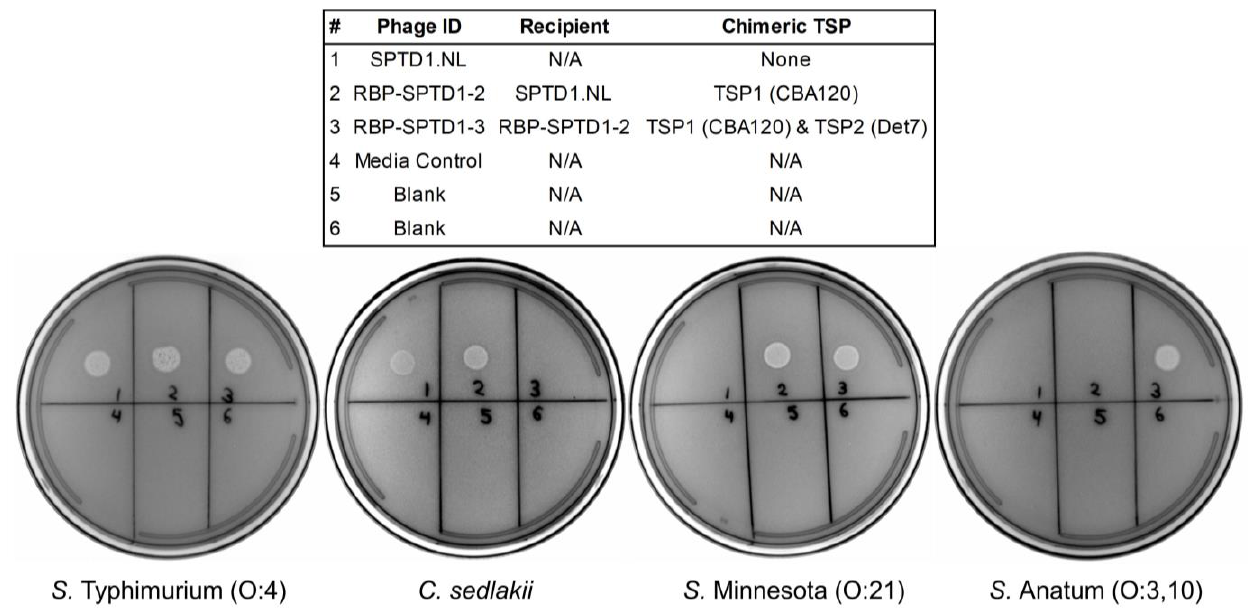
Figure 4. TSP chimeras of SPTD1.NL expand coverage of Salmonella and eliminate cross-reactivity with Citrobacter . Each phage preparation (1 × 10 8 PFU/mL) was tested for specificity by spotting 4 µL on bacterial lawns. The appearance of a circular transparent spot is evidence of phage activity against the bacterial strain. Agar plates were imaged using a Gel Doc EZ Imager (Bio-Rad Laboratories, Hercules, CA, USA). The legend indicates the identity of each spot number including the original recipient phage and donor chimeric TSP. Bacterial strain information is provided separately (Table S1). The S. Anatum strain used was SLR 377. Media control indicates a spot without phages (TSB only), whereas blank is used to indicate an unused